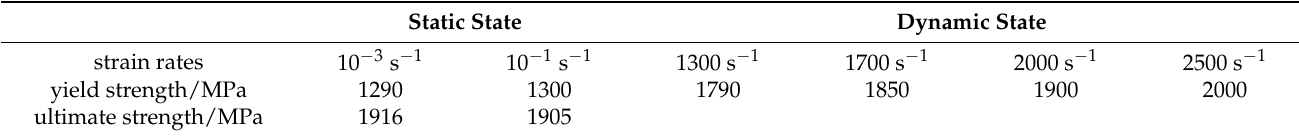
Table 2. Mechanical properties under different strain